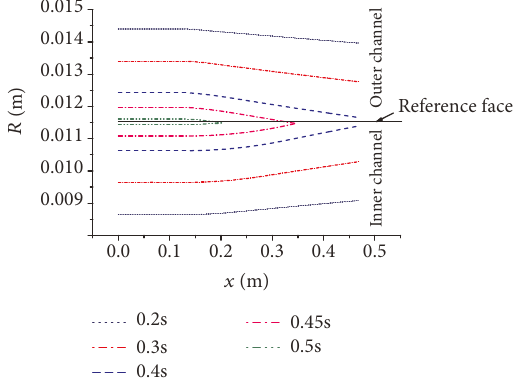
Figure 8: Burning surfaces at di ff erent